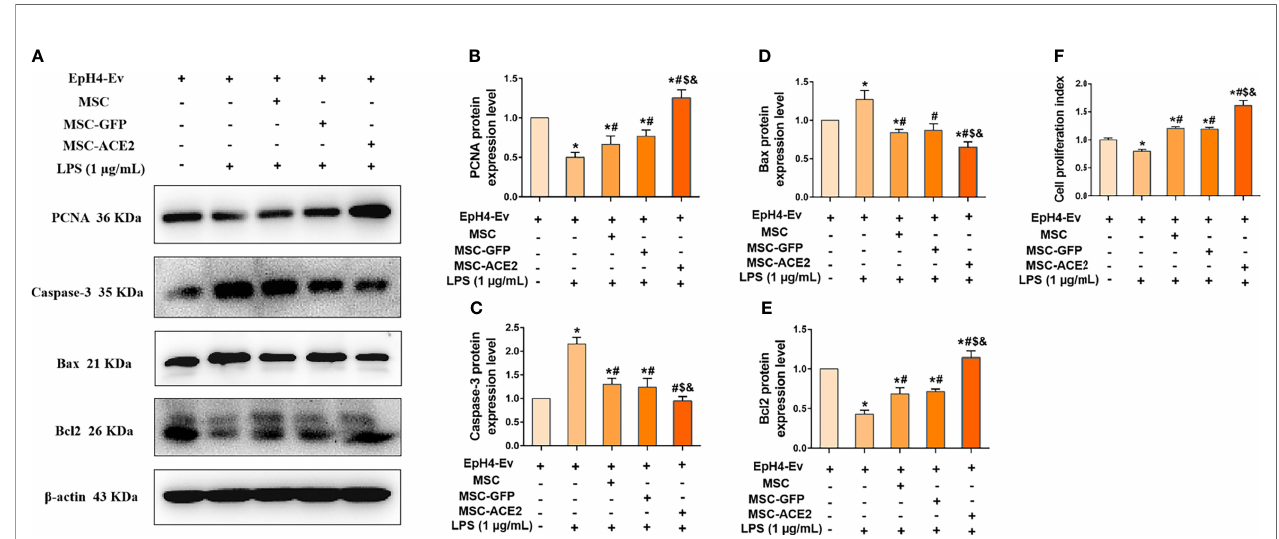
FIGURE 5 | MSC-ACE2 promotes the proliferation of EpH4-Ev cells and inhibits the apoptosis of EpH4-Ev cells. (A) Detection of relative protein expression levels of PCNA, Caspase-3, Bax, and Bcl-2 by Western blot; (B – E) Statistics of the PCNA, Caspase-3, Bax, and Bcl-2 Western blot results (n = 4). (F) CCK8 detects EpH4- Ev cells proliferation (n = 6). Experiments were repeated three times and data were presented as the mean ± SEM. * P < 0.05 vs. EpH4-Ev; # P < 0.05 vs. LPS; $ P < 0.05 vs. MSC; & P < 0.05 vs.